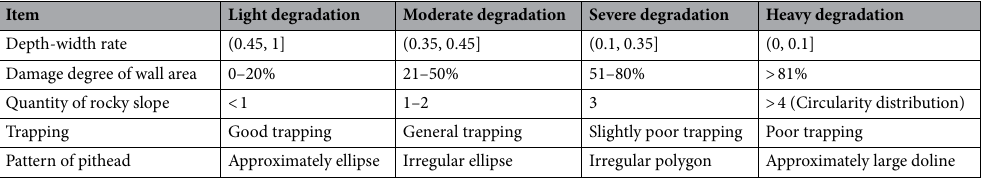
Table 1. Degradation classification of karst